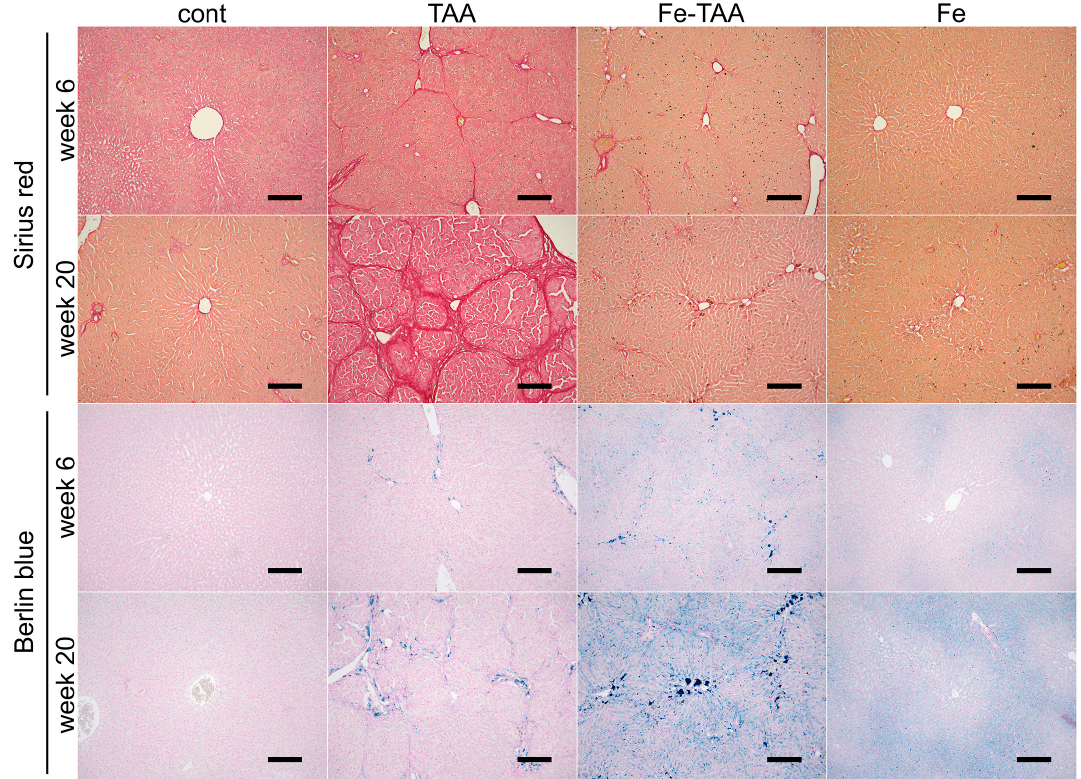
Figure 3. Sirius red ( upper ) and Berlin blue ( lower ) images of the liver at weeks 6 and 20. Collagen deposits stain red with Sirius red, while iron deposits stain blue with Berlin blue. Bar: 200 µm.